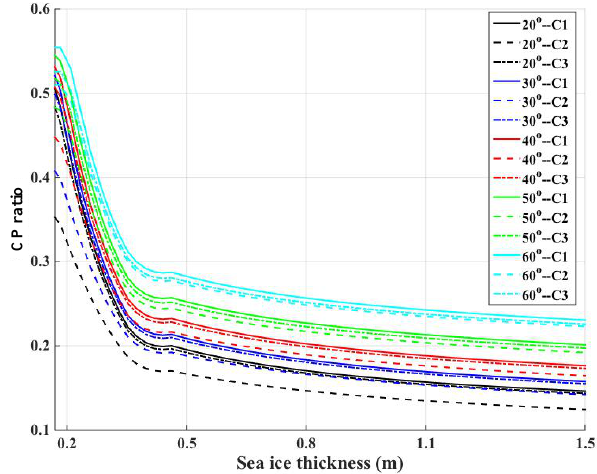
Figure 7. Sensitivity of the CP ratio to the small-scale roughness ( x axis in log scale). The standard deviation of the surface slope σ is fixed at 0.1. Black, blue, red, green and cyan colors are for 20, 30, 40, 50, and 60 ◦ incidence angles, respectively. In the legend, C1, C2, and C3 denote the three cases of small-scale surface rough- ness respectively (C1: s = 0.031cm, l = 1.26cm; C2: s = 0.12cm, l = 1.45cm; C3: s = 0.11cm, l =